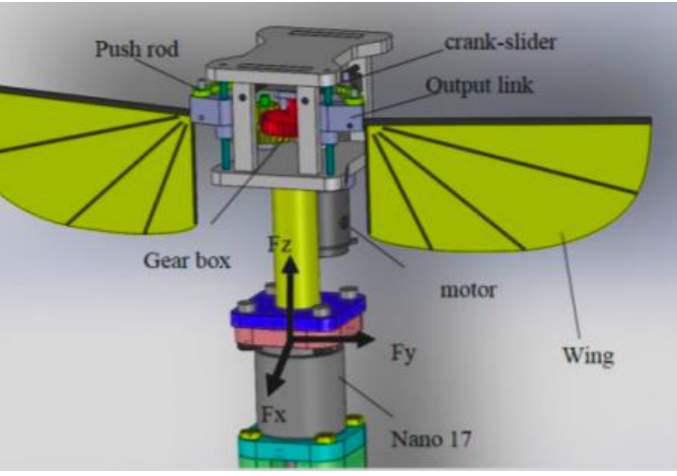
Figure 18. Mechanism for flapping to analyse wing deformations [68].